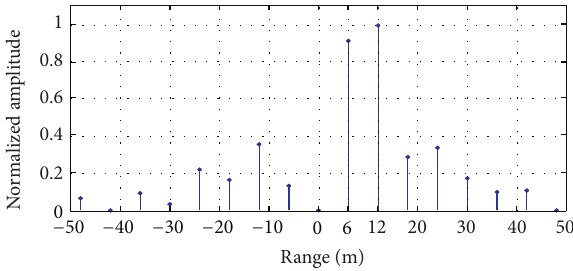
Figure 13: Retrieved signal peaks with two targets placed between 0 and